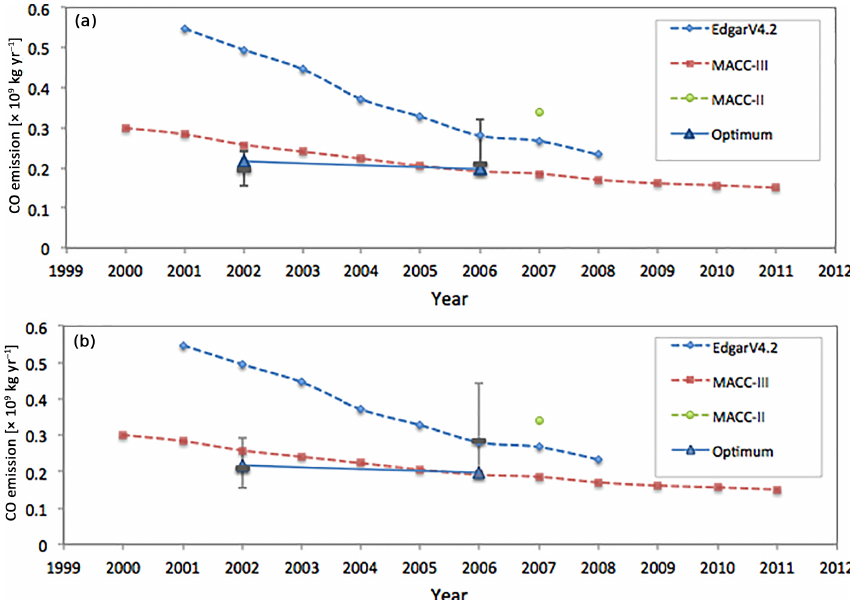
Figure 13. CO emissions in totals per year for the 200 × 200km 2 area around Madrid, comparing inversion and inventory estimates. Blue triangles, solid line: inversion results for the year 2002 and 2006; blue dotted: EdgarV4.2; green: TNO-MACC-II; red dotted: TNO-MACC- III. The grey error bars and thick grey bar represent the range and the mean of the solutions obtained in various sensitivity tests (see text): (a) emission estimations based on EdgarV4.2 prior only; (b) including other prior emissions in the WRF model for optimization (see text). The uncertainty of the Edgar and MACC emission inventory estimates are estimated at 50–200% (Kuenen et al.,